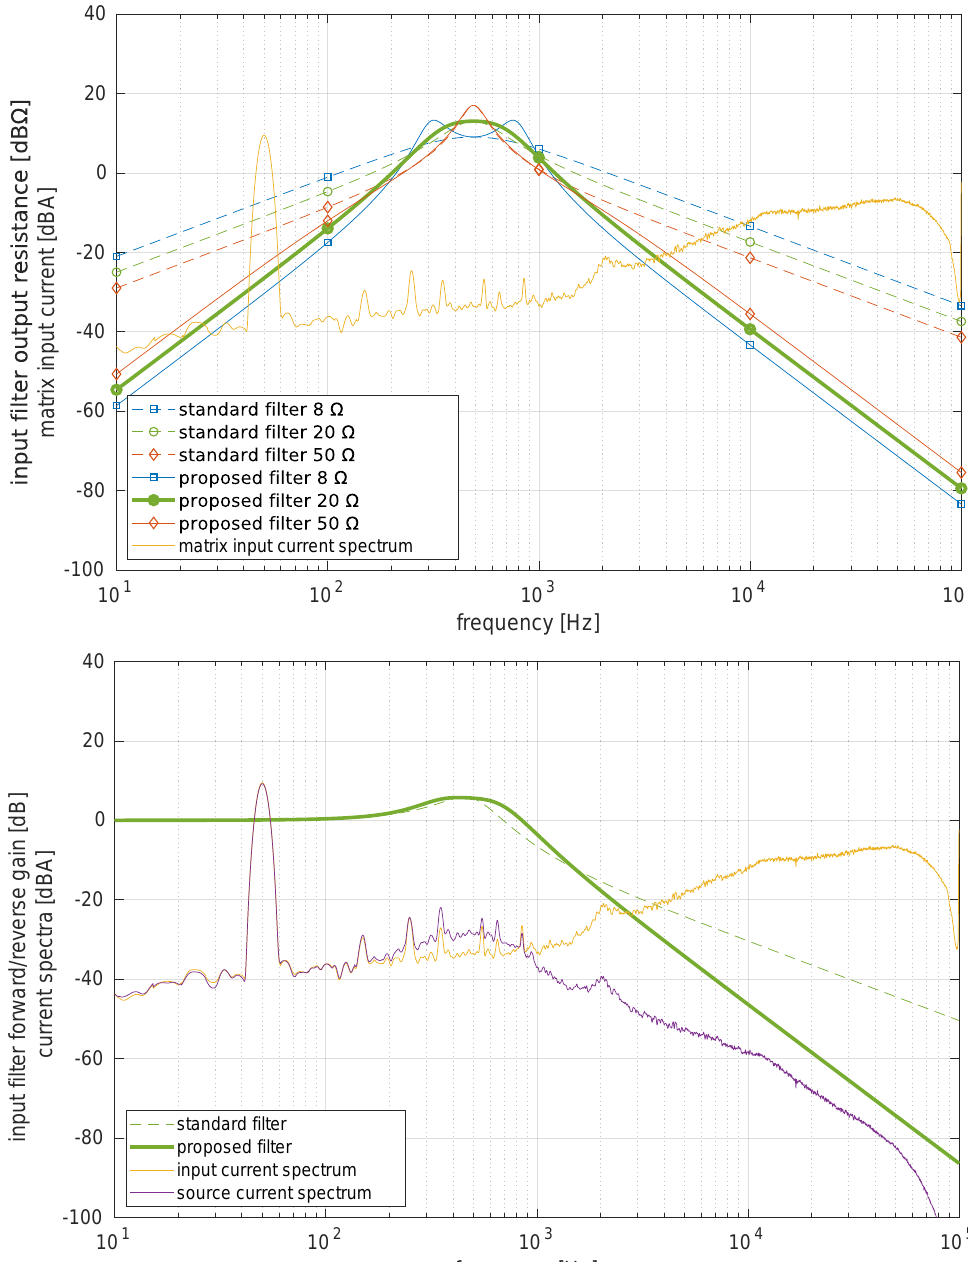
Figure 5. Input filter behavior: output resistance and gain on the top and bottom panel, respectively. Input and source current spectrum on the top and bottom panel, respectively. In the top panel, the thin yellow line represents the spectrum of the matrix input current i 2 ≡ i I , while the thin dashed lines represent the filter output resistance for various values of R . Larger